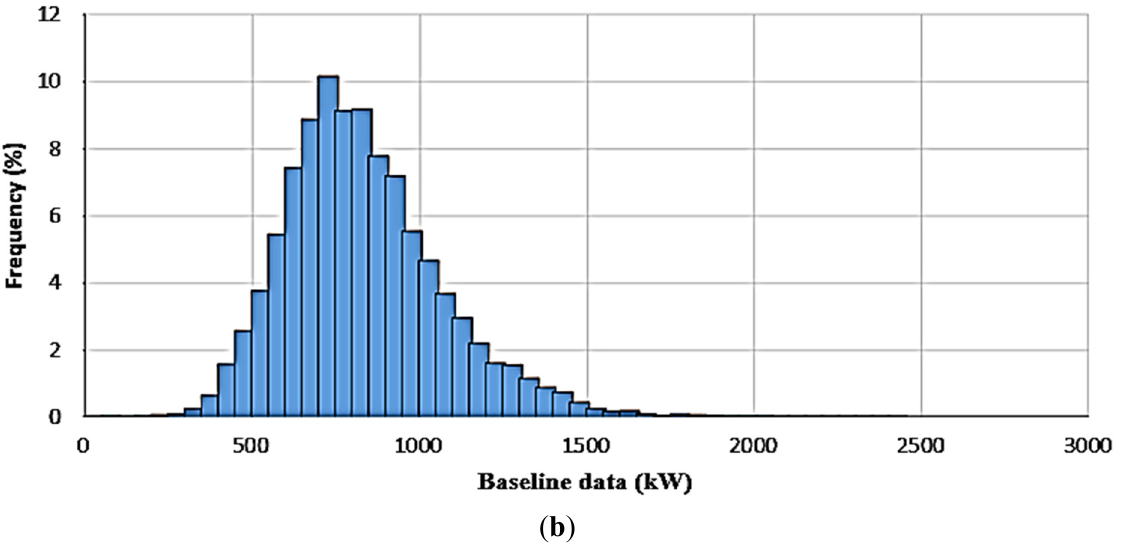
Figure 3. ( a ) The yearly baseline data load profile of the proposed tourist village in the study; ( b ) The baseline data load histogram of the proposed tourist village in the